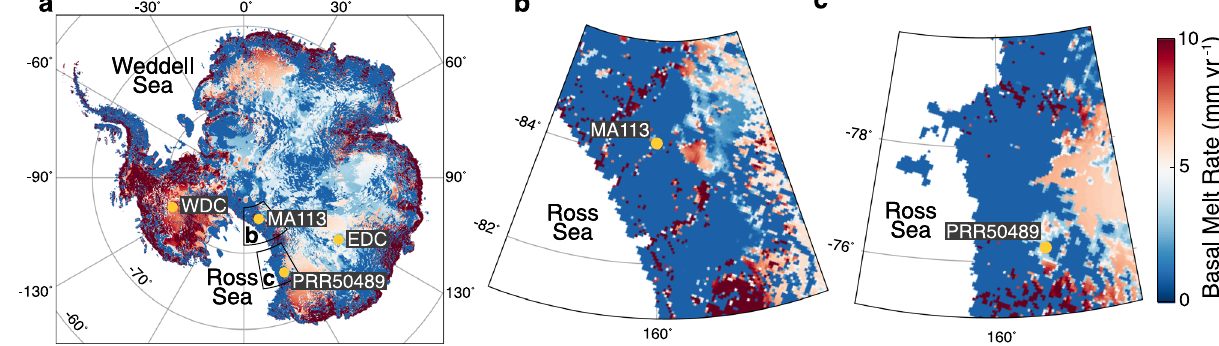
Fig. 1 | Antarctic mean basal melt rate. a Map of estimated modern mean basal melt rate 67 truncated at 10mmyr − 1 . b Map zoomed in to show basal melt rate near location of MA113. c Map zoomed in to show basal melt rate near location